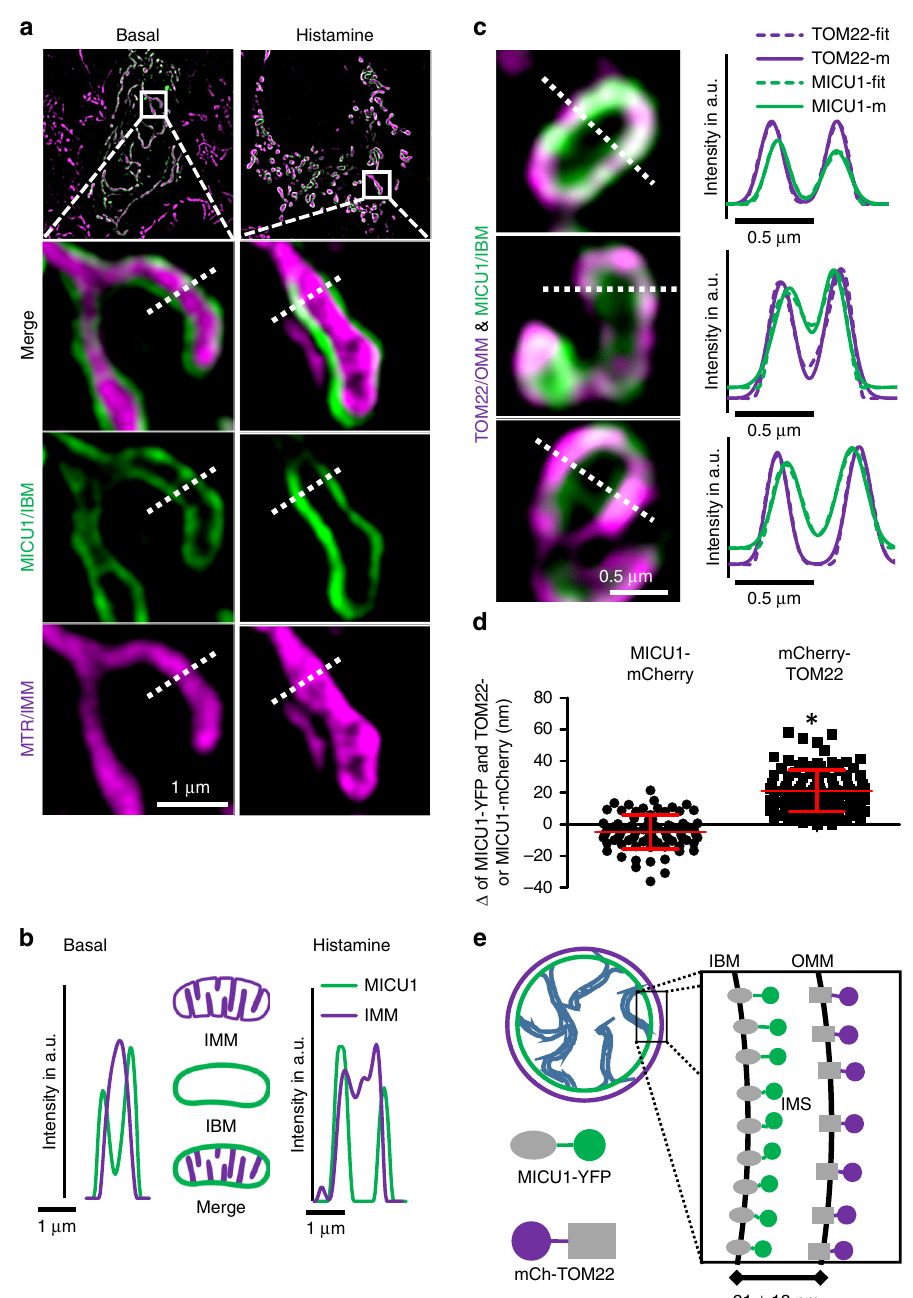
Fig. 1 Super-resolution SIM microscopy localizes MICU1 to the IBM. a Cells were transiently transfected with MICU1-YFP (green), then stained with Mitotracker Red FM (MTR) (magenta) and examined using simultaneous dual-color 3D-SIM either under resting conditions, or 4min after stimulation with 100 µ M histamine. The upper panels provide an overall view of the mitochondria, and the dashed squares indicate the regions shown magni fi ed below. The fi gures show merges of MICU1-YFP and MTR, along with MICU1-YFP ( MICU1 ) and IMM ( MTR ) signals alone. No changes in the distribution of MICU1-YFP (nor IMM staining) were observed upon stimulation with histamine. b Line plots of MICU1 (green line) and the IMM staining with MTR (magenta line) of regions marked with dashed white lines in a are shown. A clear sub mitochondrial localization of MICU1 to the IBM is visible. c HeLa cells transfected with MICU1-YFP (green) and mCherry-TOM22 (magenta) were imaged using simultaneous dual-color 3D-SIM. Left panels show representative images. Right panels show line plots through mitochondria at locations indicated by the white dashed lines. By subjecting both channels (TOM22-m (magenta line), MICU1-m (green line)) to a double Gaussian- fi t for each individual line (TOM22- fi t (dotted magenta line), MICU1- fi t (dotted green line) (right panels), the peaks of both distributions could be determined with sub-pixel accuracy. d HeLa cells transfected with MICU1-YFP and mCherry-TOM22 or MICU1-mCherry were analyzed regarding the relative distance between the YFP and mCherry distributions like shown in c . Data are shown as dot plots with the mean±SD as red middle line and whiskers, respectively ( n mCherry-TOM22 = 105, n MICU1-mCherry) = 80). * P <0.05 vs. respective control conditions carried out with unpaired double-sided T -test. e Schematic illustration of the mitochondrial inner boundary membrane and outer membrane showing the determined spacing between MICU1 and TOM22 of 21±3nm (mean±SD). This value matches published distances between the OMM and IMM (lower right). Images and analyses were obtained from 2 to 5 mitochondria in at least 3 cells in each of 8 independent experiments ( n mCherry-TOM22 = 8/24/105, n MICU1-mCherry) = 8/40/80). Source data are provided as a Source Data fi